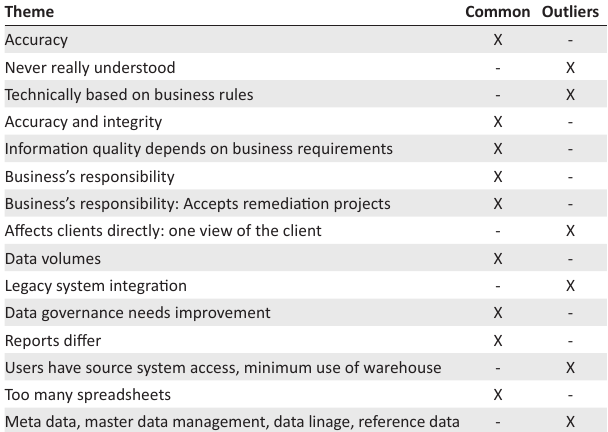
TABLE 3: Information quality survey results summarised, September 2015 – A: Information quality.